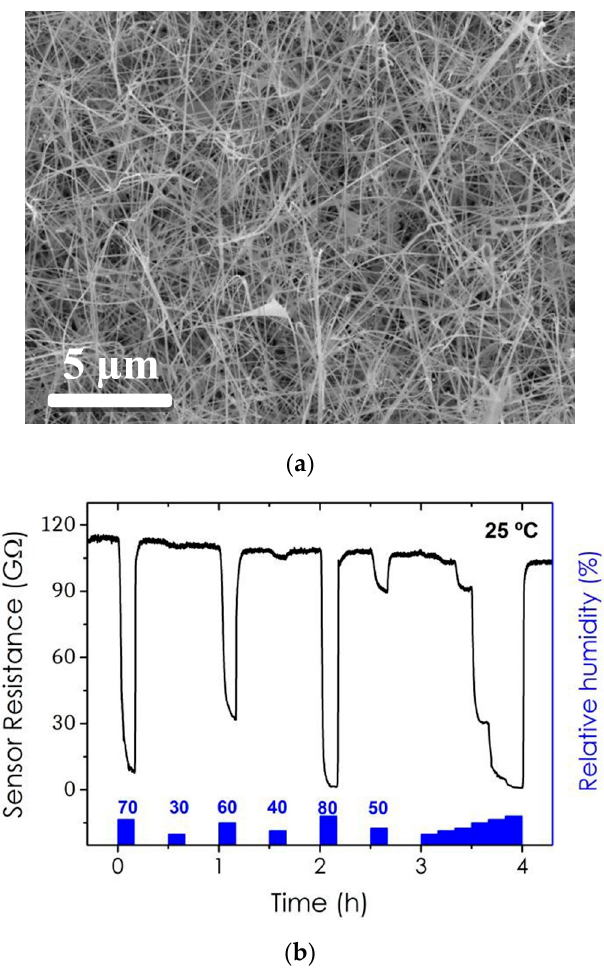
Figure 2. ( a ) Gallium oxide nanowires grown via gold-assisted vapor-liquid-solid process using chemical vapor deposition techniques and carbothermal reduction at 800 °C; ( b ) Gallium oxide nanowire-based gas sensor’s resistance evolution towards varying concentrations of relative humidity in synthetic air at room